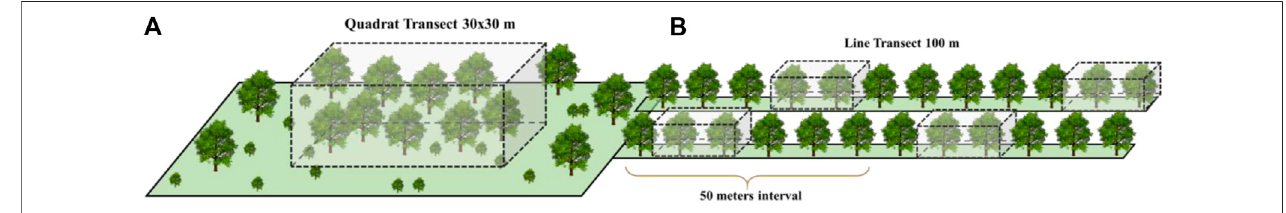
FIGURE 4 | Field survey methods used for various land-use.